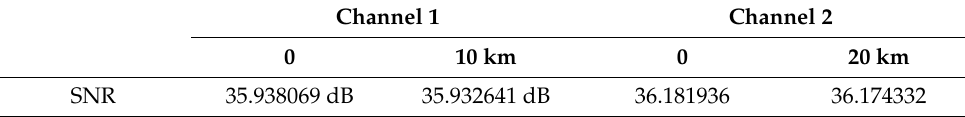
Table 3. The signal-noise ratio (SNR) versus transmission distance before and after MMF.